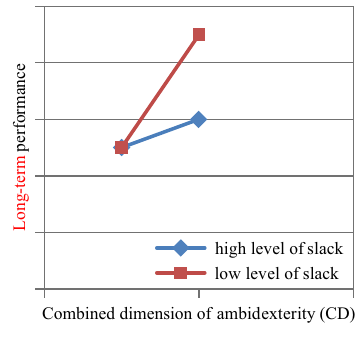
Fig. 1. Conditional effects plot of BD on different levels of organizational slack